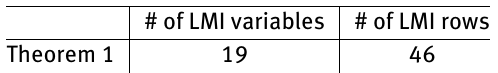
Table 1: Number of LMI variables and constraints for Theorem 1 (Example 1).